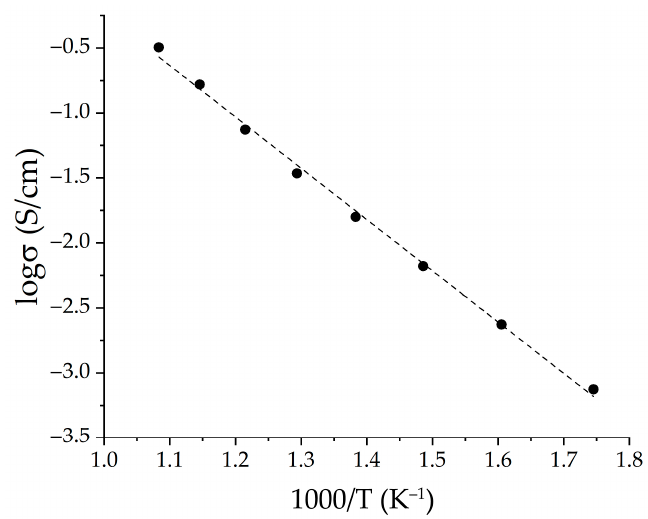
Figure 9. Arrhenius plot for NiO—SDC coating in the temperature range of 300–650 °C (the black markers indicate experimental values, and the dashed line is the result of linear approximation).